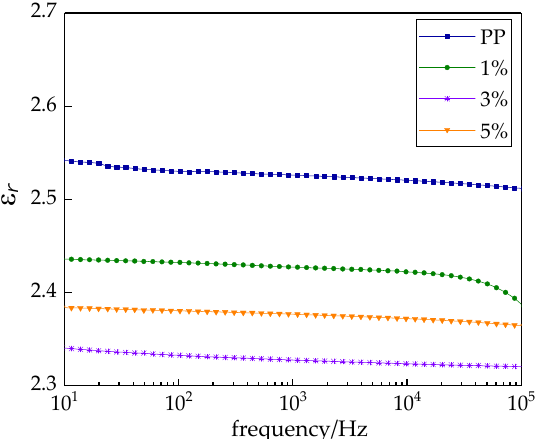
Figure 6. Frequency dependences of relative permittivity of MgO/PP composite.